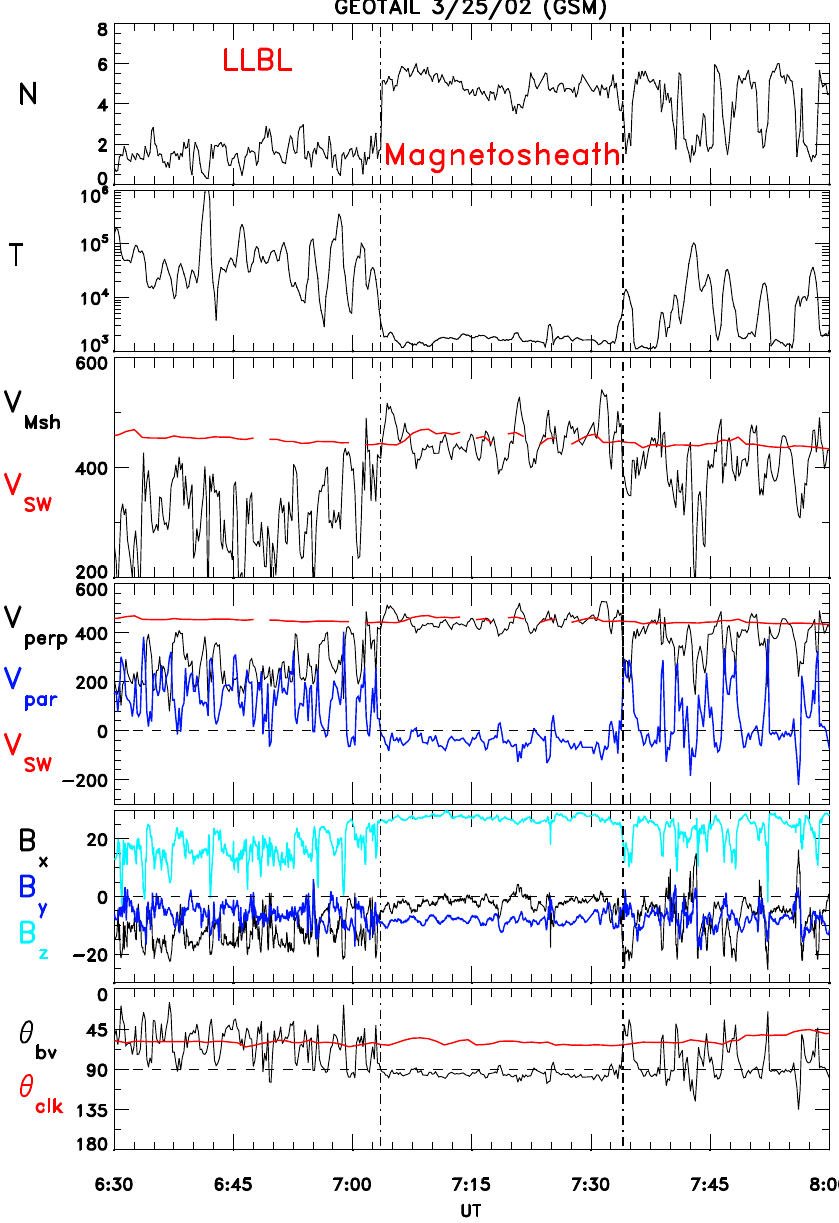
Fig. 1. Event on 25 March 2002. From top to bottom: the proton density in cm − 3 , proton temperature in K. V Msh and V sw , in kms − 1 , are the magnetosheath and solar wind speeds, respectively. V par and V perp are, respectively, the flow velocities parallel and perpendicular to the local magnetic field. The Geocentric Solar Magnetospheric (GSM) components of the magnetic field Bx , y , z are measured in nT. θ bv is the angle between the local magnetic field and the ion velocity. θ clk is the IMF clock angle, i.e., the polar angle in the GSM YZ